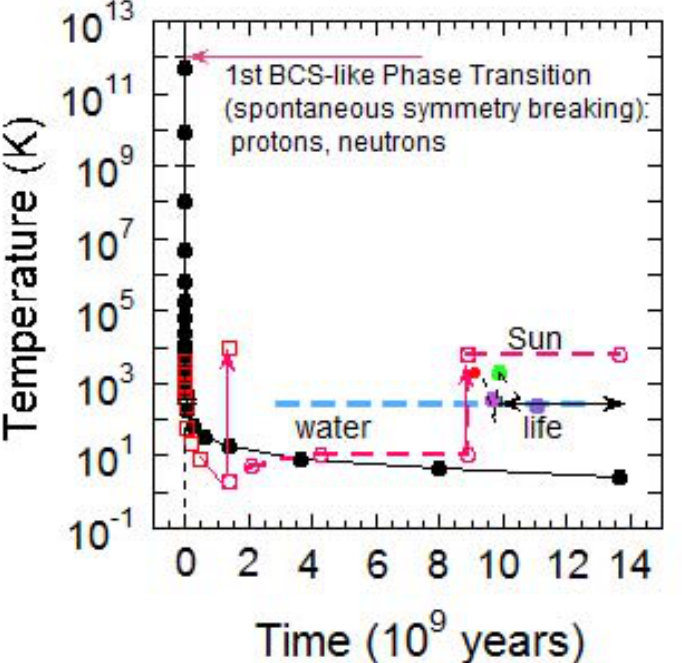
Figure 2. The CMB temperature (solid line and filled dots) as a function of time in linear scale in the Universe and the hydrogen gas temperature (squares) with the discontinuities (arrows) for the formation of first stars and the sun. The earth formation and the onset of life dots with vaporization periods of the Earth surface by meteorites. Green and blue filled dots indicate the appearance on Earth of thermophile and cyanobacteria